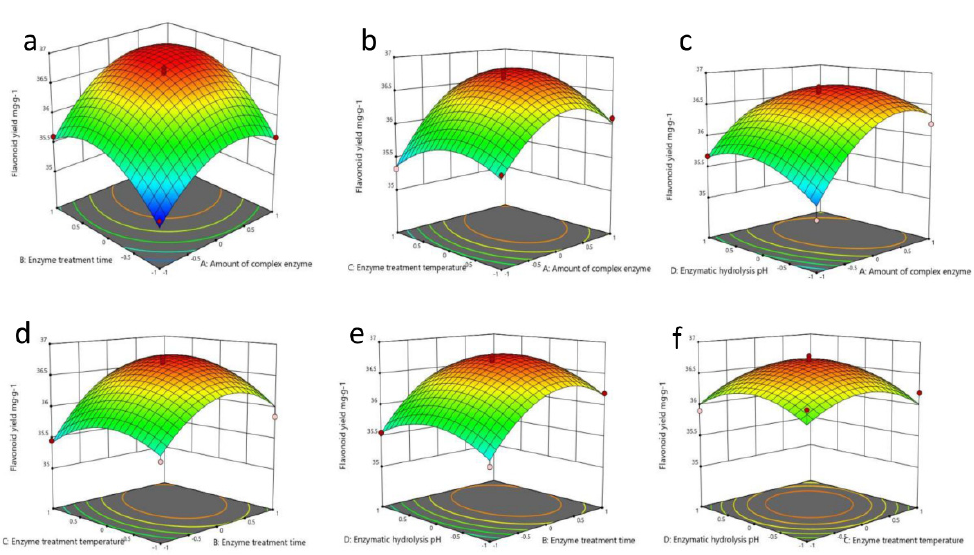
Figure 2. 3D response surface plots of the optimization: ( a ) interaction between the enzyme amount and the enzyme treatment time; ( b ) interaction between the enzyme amount and temperature; ( c ) interaction between the enzyme amount and pH; ( d ) interaction between the enzyme treatment time and temperature; ( e ) interaction between the enzyme treatment time and pH; ( f ) interaction between the temperature and pH.